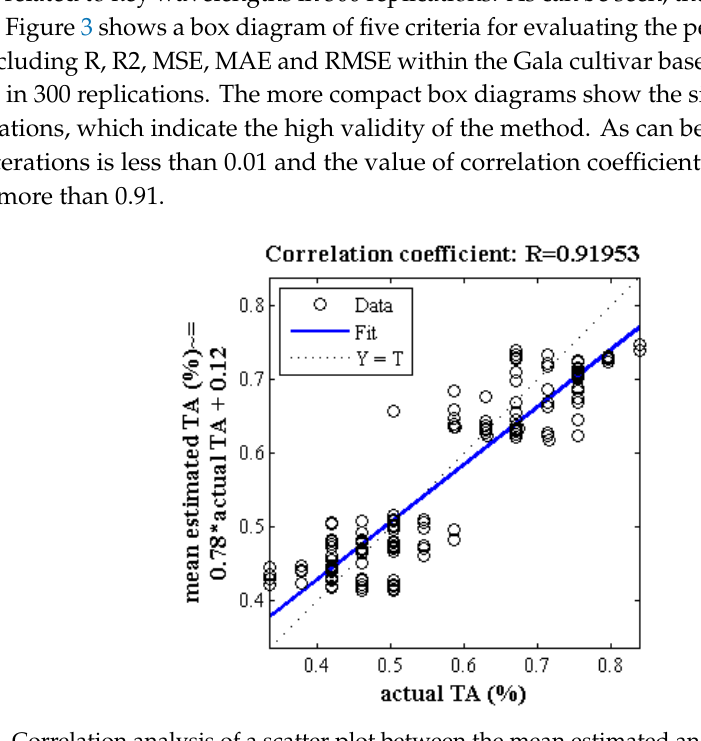
( b ) Figure 3. Box of five criteria for evaluating the performance of ANN-PSO algorithm for estimating the TA of Gala cultivar based on spectral data of key wavelengths. ( a ) Error criteria, ( b ) Correlation coefficients and determination. 3.4.2. Taste Index Figure 4 illustrates the correlation diagram of the mean estimated and measured properties of taste index of Gala apple in 300 iterations. As can be seen, based on the key wavelength, the correlation coefficient between the mean estimated and measured values is about 0.93. Figure 5 examines the performance of the ANN-PSO for estimating the properties of the taste index using three criteria related to error and correlation coefficients and determination. As can be seen, in more than half of the iterations, RMSE is less than 3. Moreover, except one iteration, the value of correlation coefficient is above 0.85.